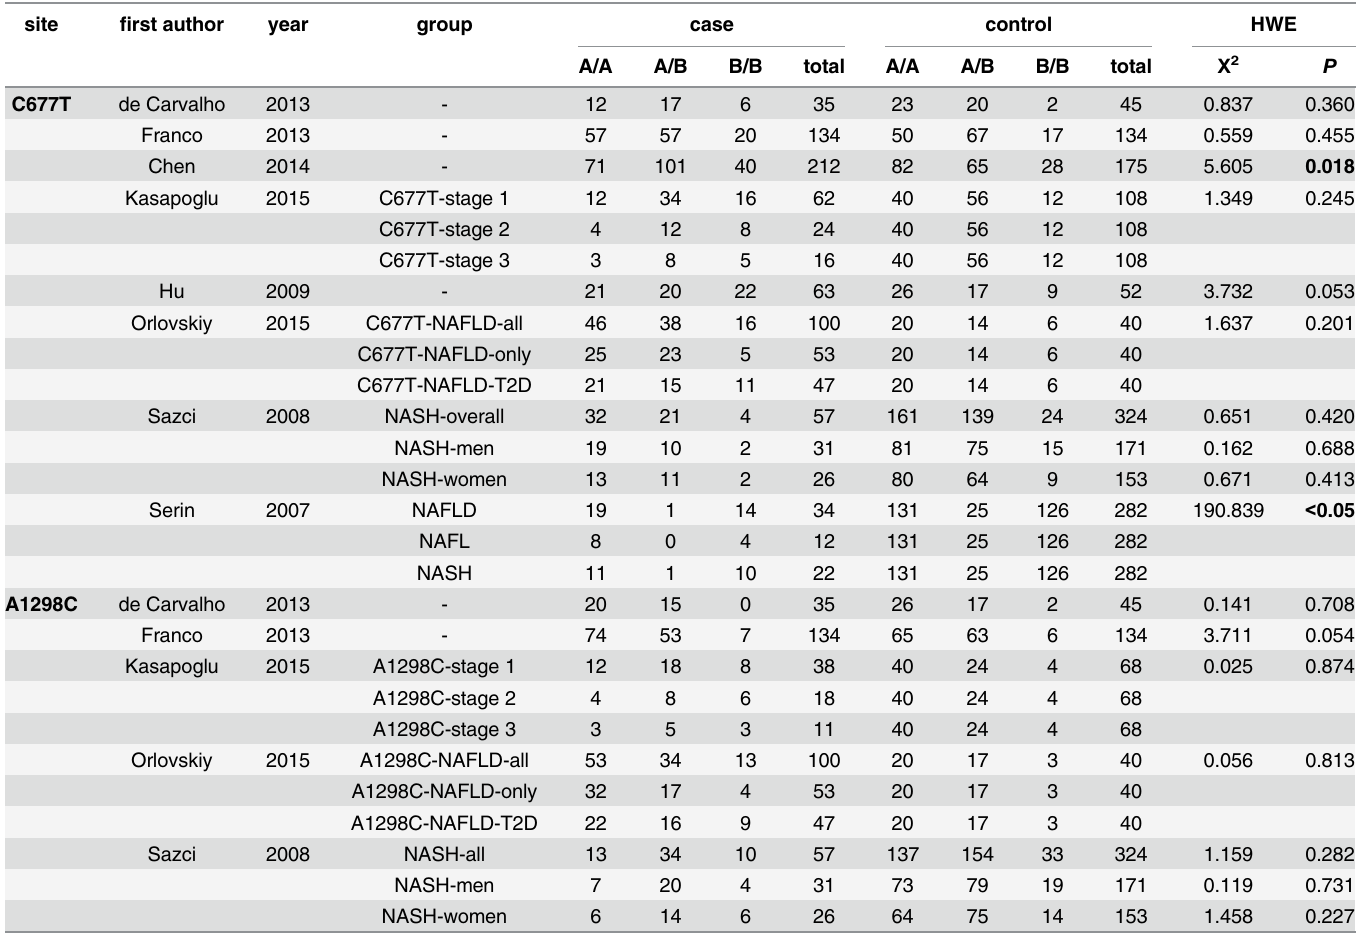
Table 2. Genotype distribution of MTHFR C677T and A1298C